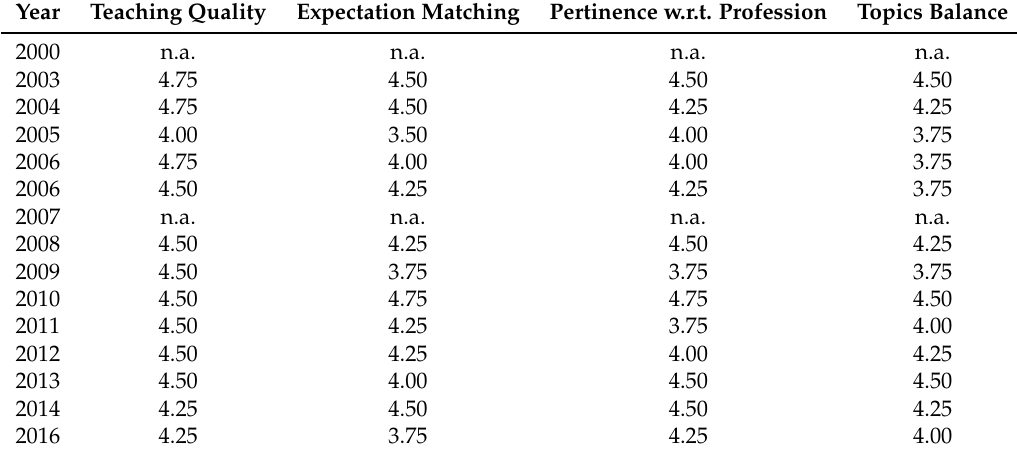
Table 2. Quality assessment performed by the attendees of the courses designed for professionals, with values ranging from 1 (worst) to 5 (best). A score is assigned regarding the overall teaching quality (teaching quality), matching of course content to expectations (expectation matching), pertinence of the course topics with respect to the profession (pertinence w.r.t profession) and balance between the topics of the course (topics balance). Average values for all of the attendees are reported. Evaluations for the years 2000 and 2007 are not